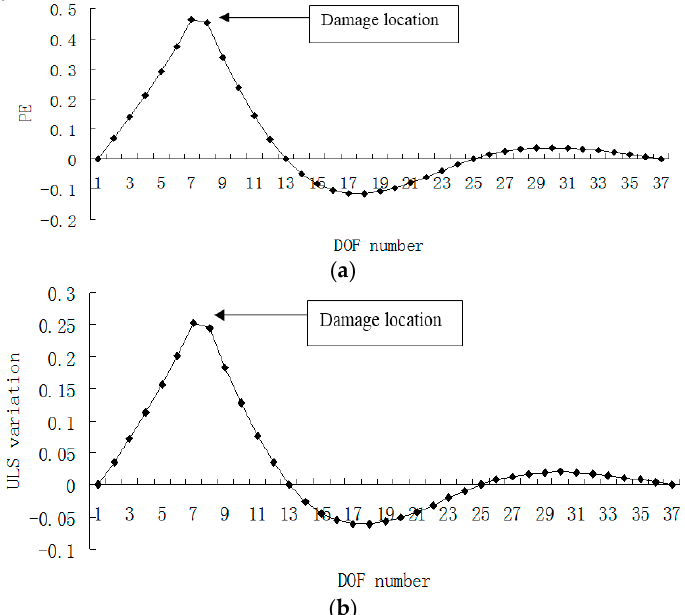
Figure 5. ( a ) Damage index (principal eigenvector (PE)) map using the first four exact modes when the defect occurred in element 7; ( b ) Damage index (uniform load surface (ULS) variation) map using the first four exact modes when the defect occurred in element 7 (×10 − 4 ).